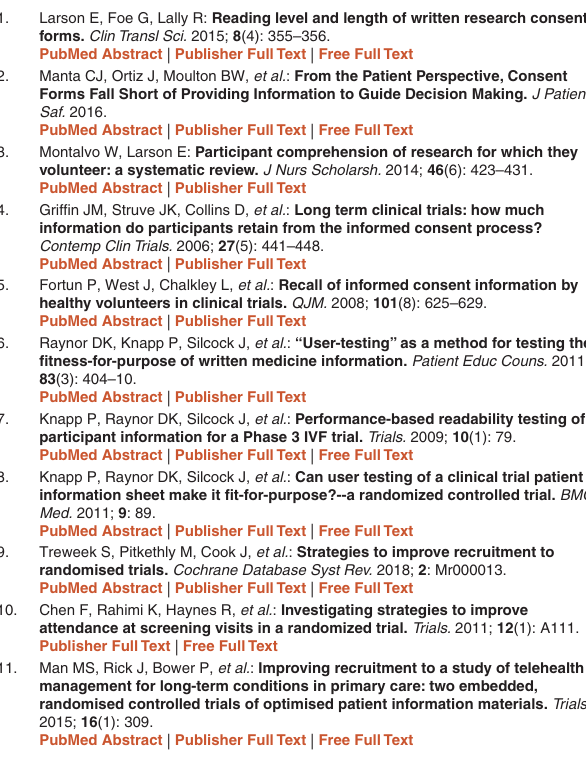
Figshare: CASPER SWAT data.csvCASPER SWAT recruitment data and evaluated information sheets. https://doi.org/10.6084/